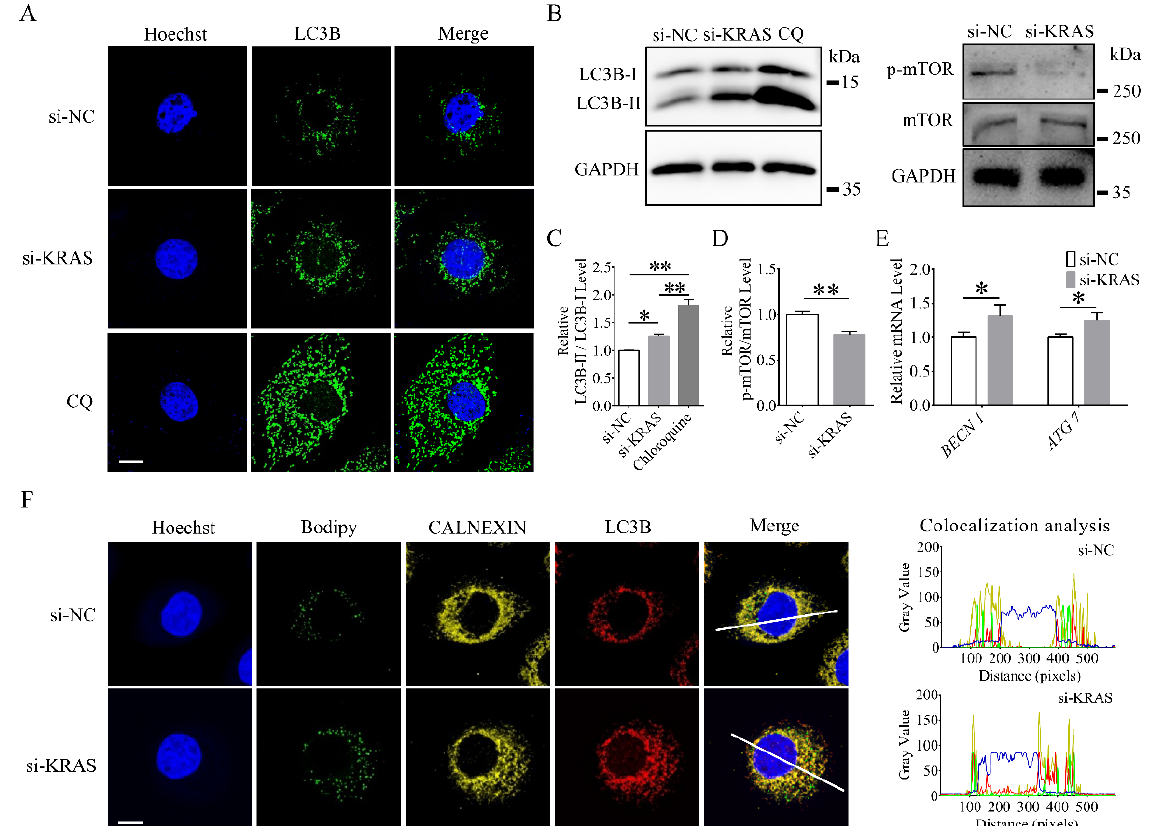
Figure 6. Effects of Kirsten rat sarcoma viral oncogene homolog (KRAS) on autophagy in MAC-T cells. ( A ) Representative immunofluorescence images of microtubule-associated protein 1 light chain 3 beta (LC3B) in MAC-T cells with or without KRAS inhibition. Bar = 10 µ m. ( B – D ) Representative Western blot images and relative protein levels of LC3B, mammalian target of rapamycin (mTOR), and p-mTOR in MAC-T. ( E ) Relative mRNA levels of beclin 1 ( BECN1 ) and autophagy-related 7 ( ATG7 ) in MAC-T cells with or without KRAS inhibition. ( F ) Representative immunofluorescence images and colocalization analysis of Bodipy, LC3B, and CALNEXIN in MAC-T cells with or without KRAS inhibition. Bar = 10 µ m. The fluorescence signals of Hoechst, Bodipy, CALNEXIN, and LC3B were represented by the blue, green, yellow, and red lines, respectively. Fluorescence colocalization was analyzed based on the white line in merged image. Significant differences are represented with * ( p < 0.05) and ** ( p < 0.01).